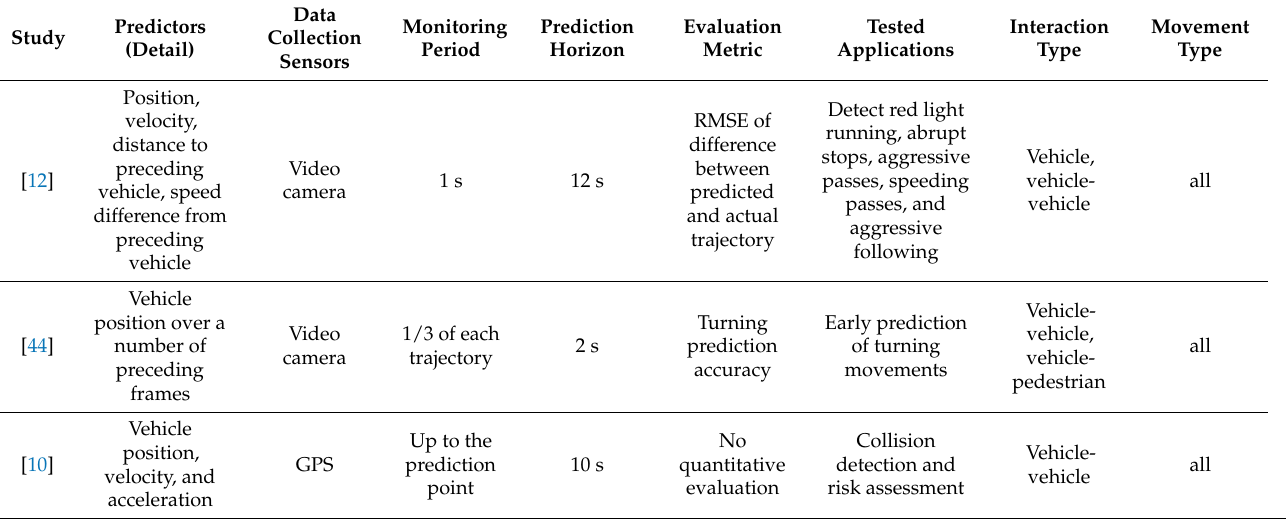
Table 2. Summary of studies on trajectory prediction for intersection